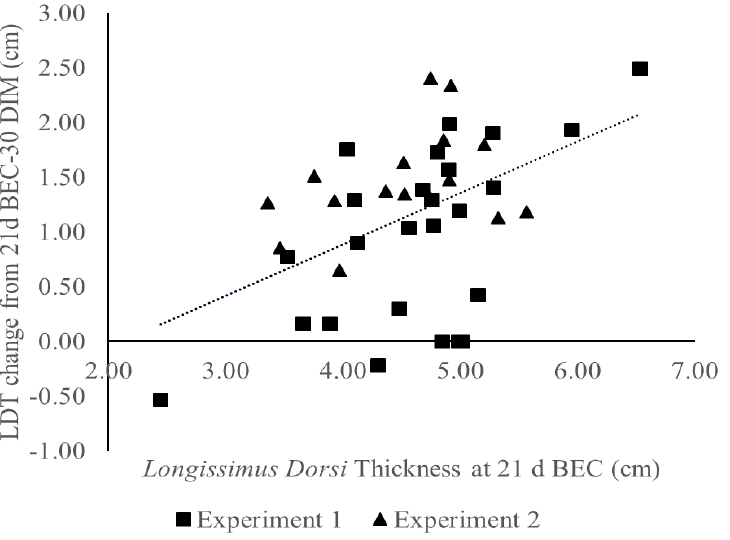
Figure 3. The relationship between longissimus dorsi thickness (LDT) at 21 d before expected calving (BEC) and the amount of LDT mobilized from 21 d BEC to 30 days in milk (DIM) from the first experiment ( ∎ ; n = 25) and the second experiment ( ▲ ; n = 16). The greater the LDT cows have at 21 d BEC, the more LDT they mobilize from three weeks prepartum through 30 DIM (R 2 = 0.37). Negative LDT mobilized is equivalent to muscle accretion over the time points measured.